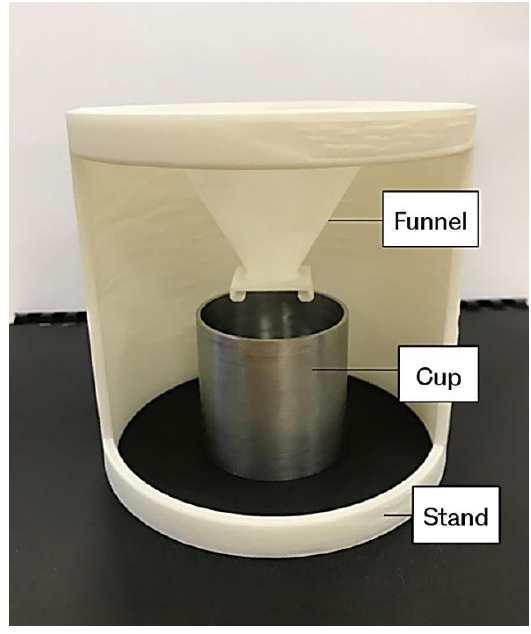
Materials 2019 , 12 , x FOR PEER REVIEW Figure 2. Bulk density measurement set-up. Figure 2. Bulk density measurement set-up.